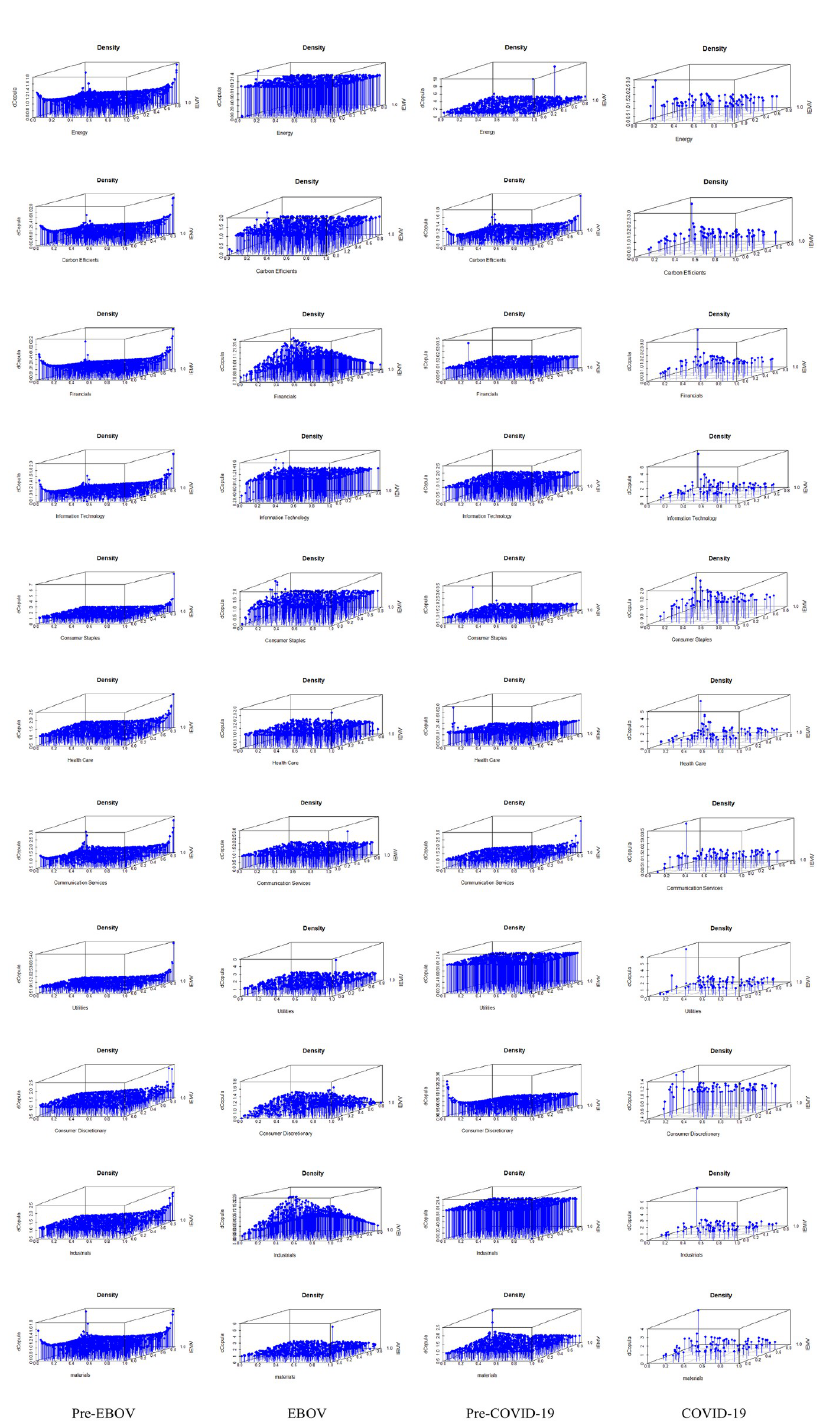
Fig 4. Scatter plot of each bivariate copula function for every four periods. The plot confirms the asymmetry and tail dependence in joint distribution at pre-EBOV and pre-COVID-19 periods ( https://ndownloader.figshare.com/